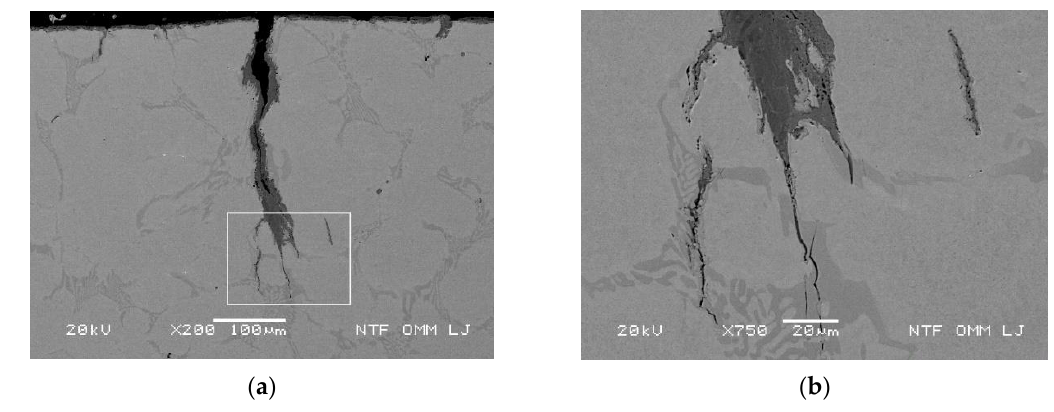
Figure 9. Deformation due to the oxide volume change and crack oxidation next to the eutectic carbide after 2500 cycles at 700 °C: ( a ) oxidation of the secondary crack and surface material deformation with marked area of the detail and, ( b ) detailed view of increased oxidation of the crack tip.